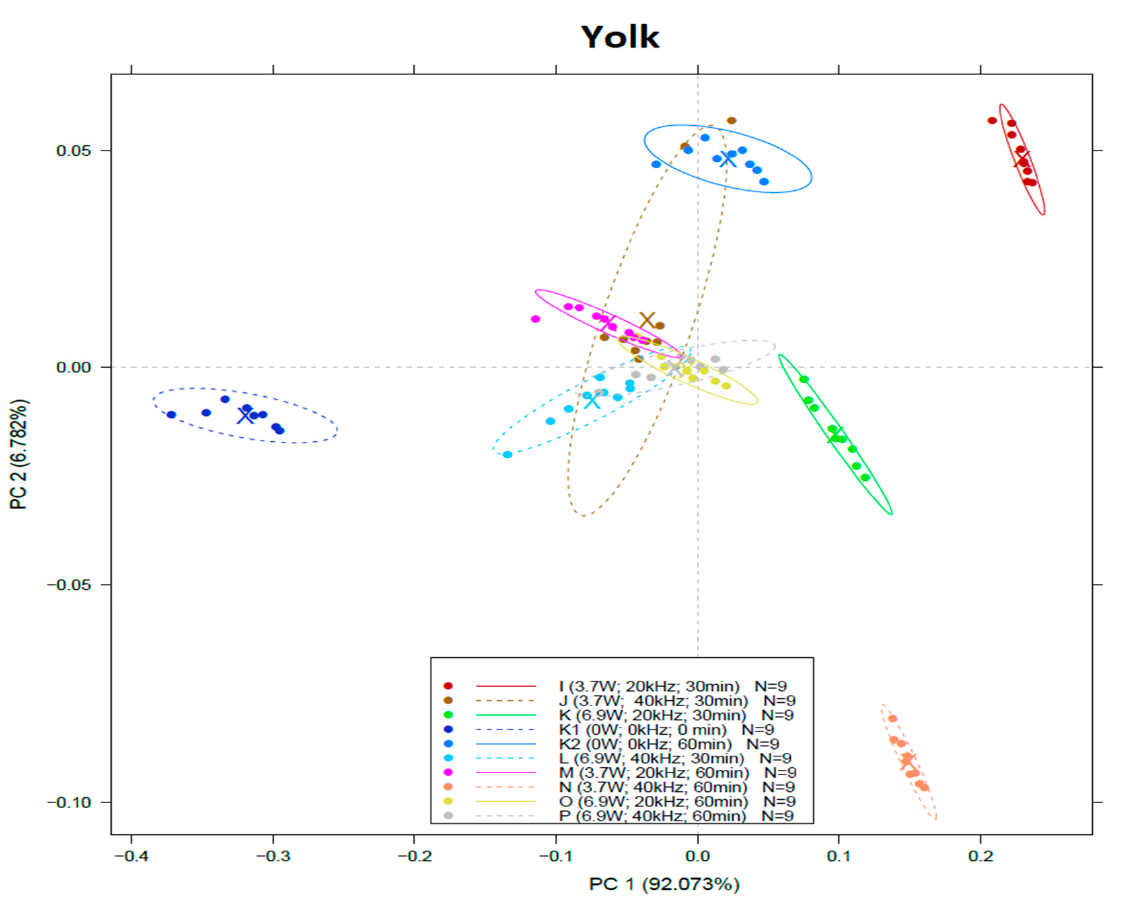
Figure 4. Score plot of principal component analysis (PCA) on spectral data of yolk within the range of 950–1630 nm.